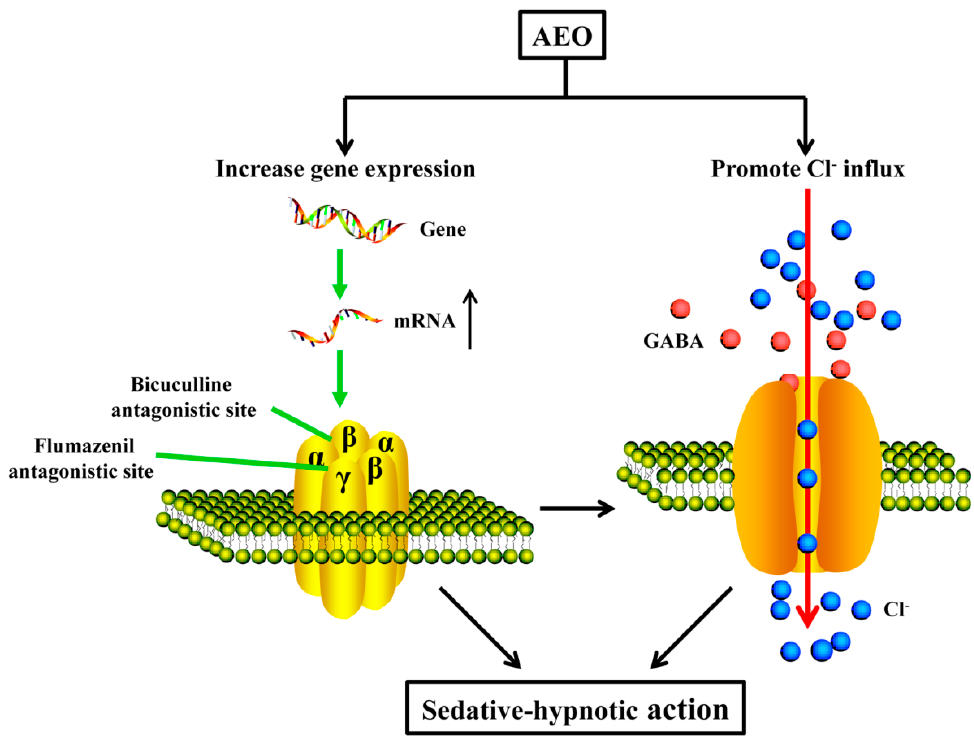
Figure 10. A schematic illustration of the proposed AEO mechanism.